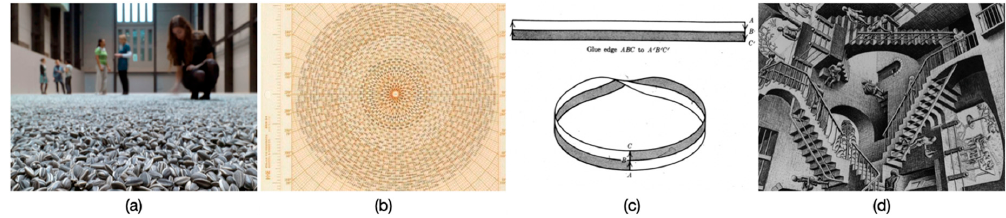
Figure 7. Examples suggested by the participants (Reprinted with permission): ( a ) Ai Wei Wei sunflower seeds, ( b ) Agnes Denes Fibonacci sequence pyramid, ( c ) Mobius strip, and ( d ) M.C. Escher staircase illusion.